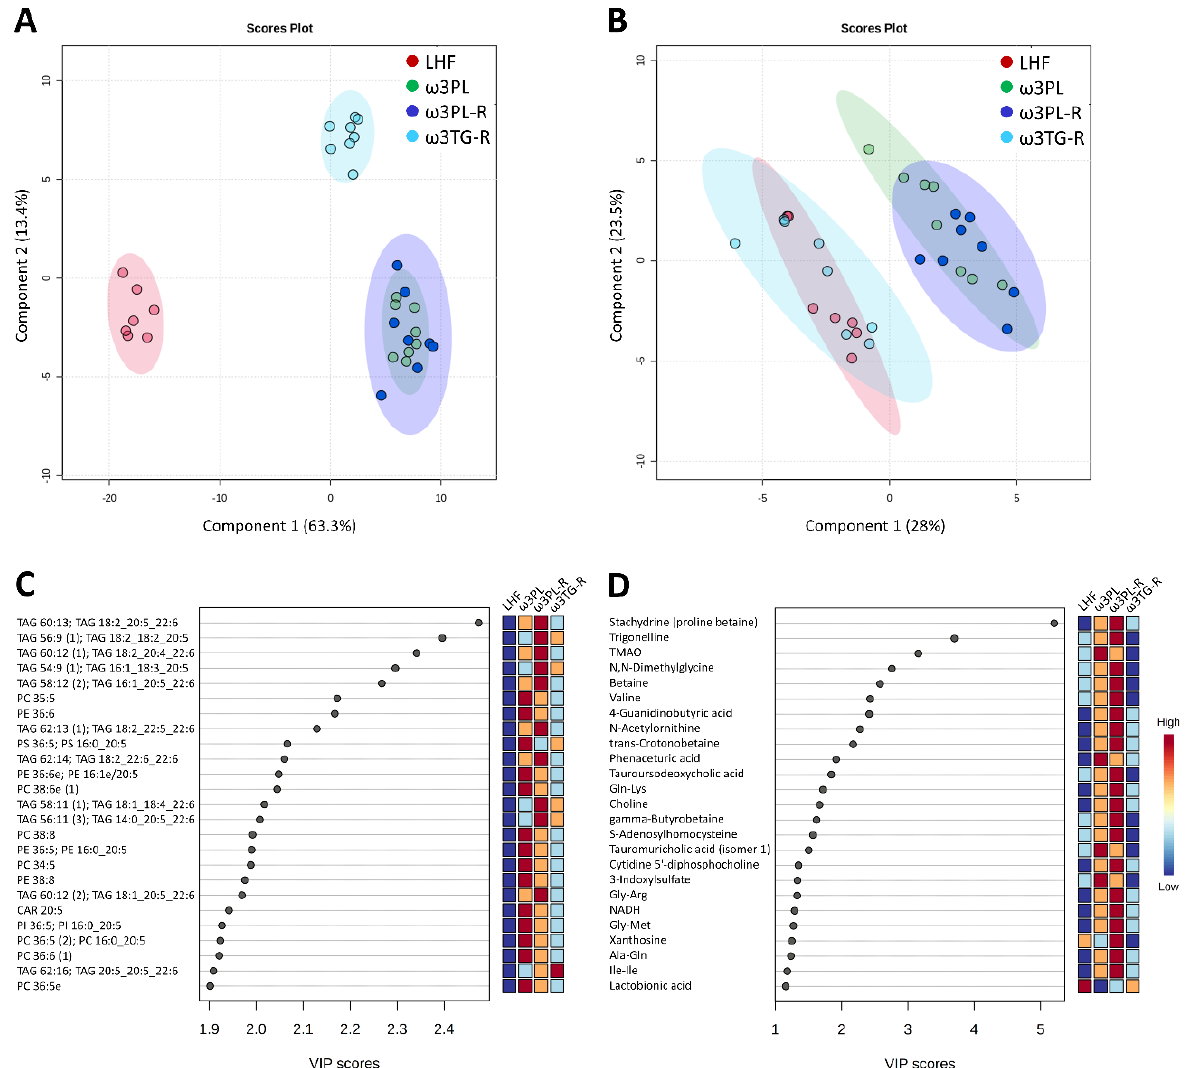
Figure 7. Four-class PLS-DA score plots of complex lipids ( A ; n = 507) and polar metabolites ( B ; n = 157) in the liver in response to dietary challenges, and the most discriminating complex lipids ( C ) and polar metabolites ( D ) based on VIP scores from PLS-DA.